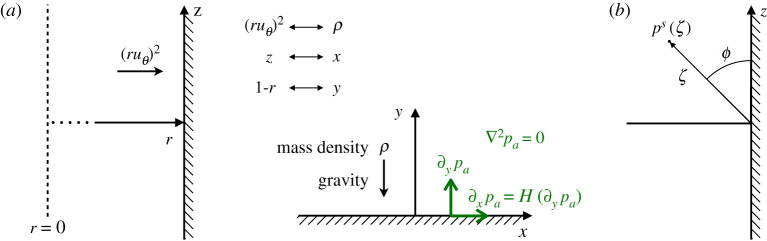
(a) Correspondence between axisymmetric flow with swirl away from the axis and the inviscid 2D Boussinesq system. Expressions involving pa illustrate that if pa is a harmonic function in the upper half-plane, then its tangential derivative is the Hilbert transform of its normal derivative. (b) Coordinates for symmetric pressure field p2Ds. (Online version in colour.)